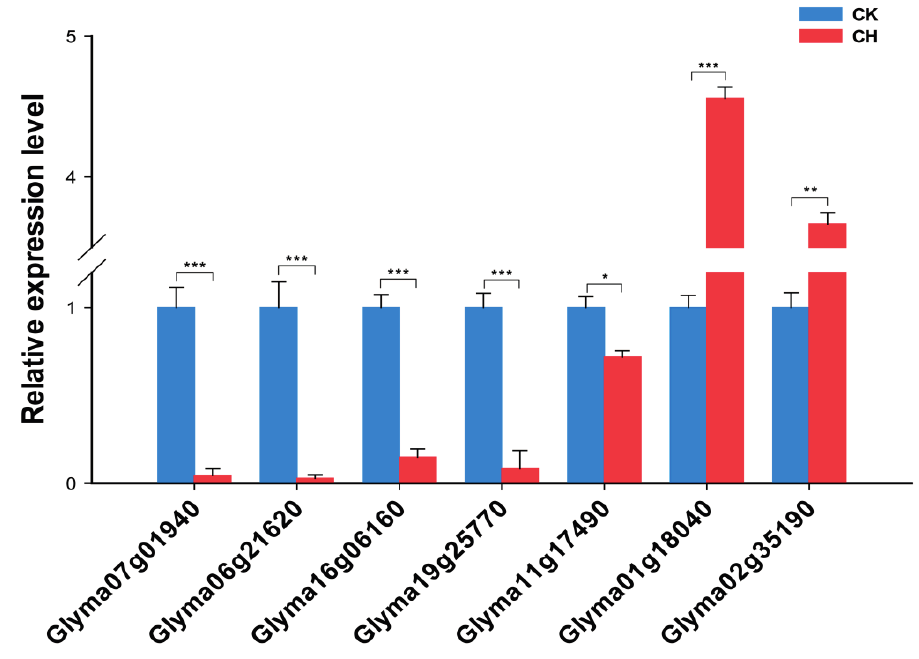
Figure 4. Expression levels of the validated target genes in low temperature-treated mature nodules. Total mRNA from cold-treated or untreated mature nodules was extracted, and RT-qPCR was used to analyze the relative expression of the selected target genes, including glyma07g01940 and glyma08g21620 targeted by gma-miR166u, glyma16g06160 and glyma19g25770 targeted by gma-miR2111f, glyma11g17490 and glyma01g18100 targeted by gma-miR171p and glyma02g35190 targeted by gma-miR169c. ELF1b was used as an internal control. The results given are averages ± SE of three biological replicates. Error bars indicate the standard deviation. Student’s t -tests were performed; statistically significant results are marked with * ( p < 0.05); ** ( p < 0.01); and *** ( p <